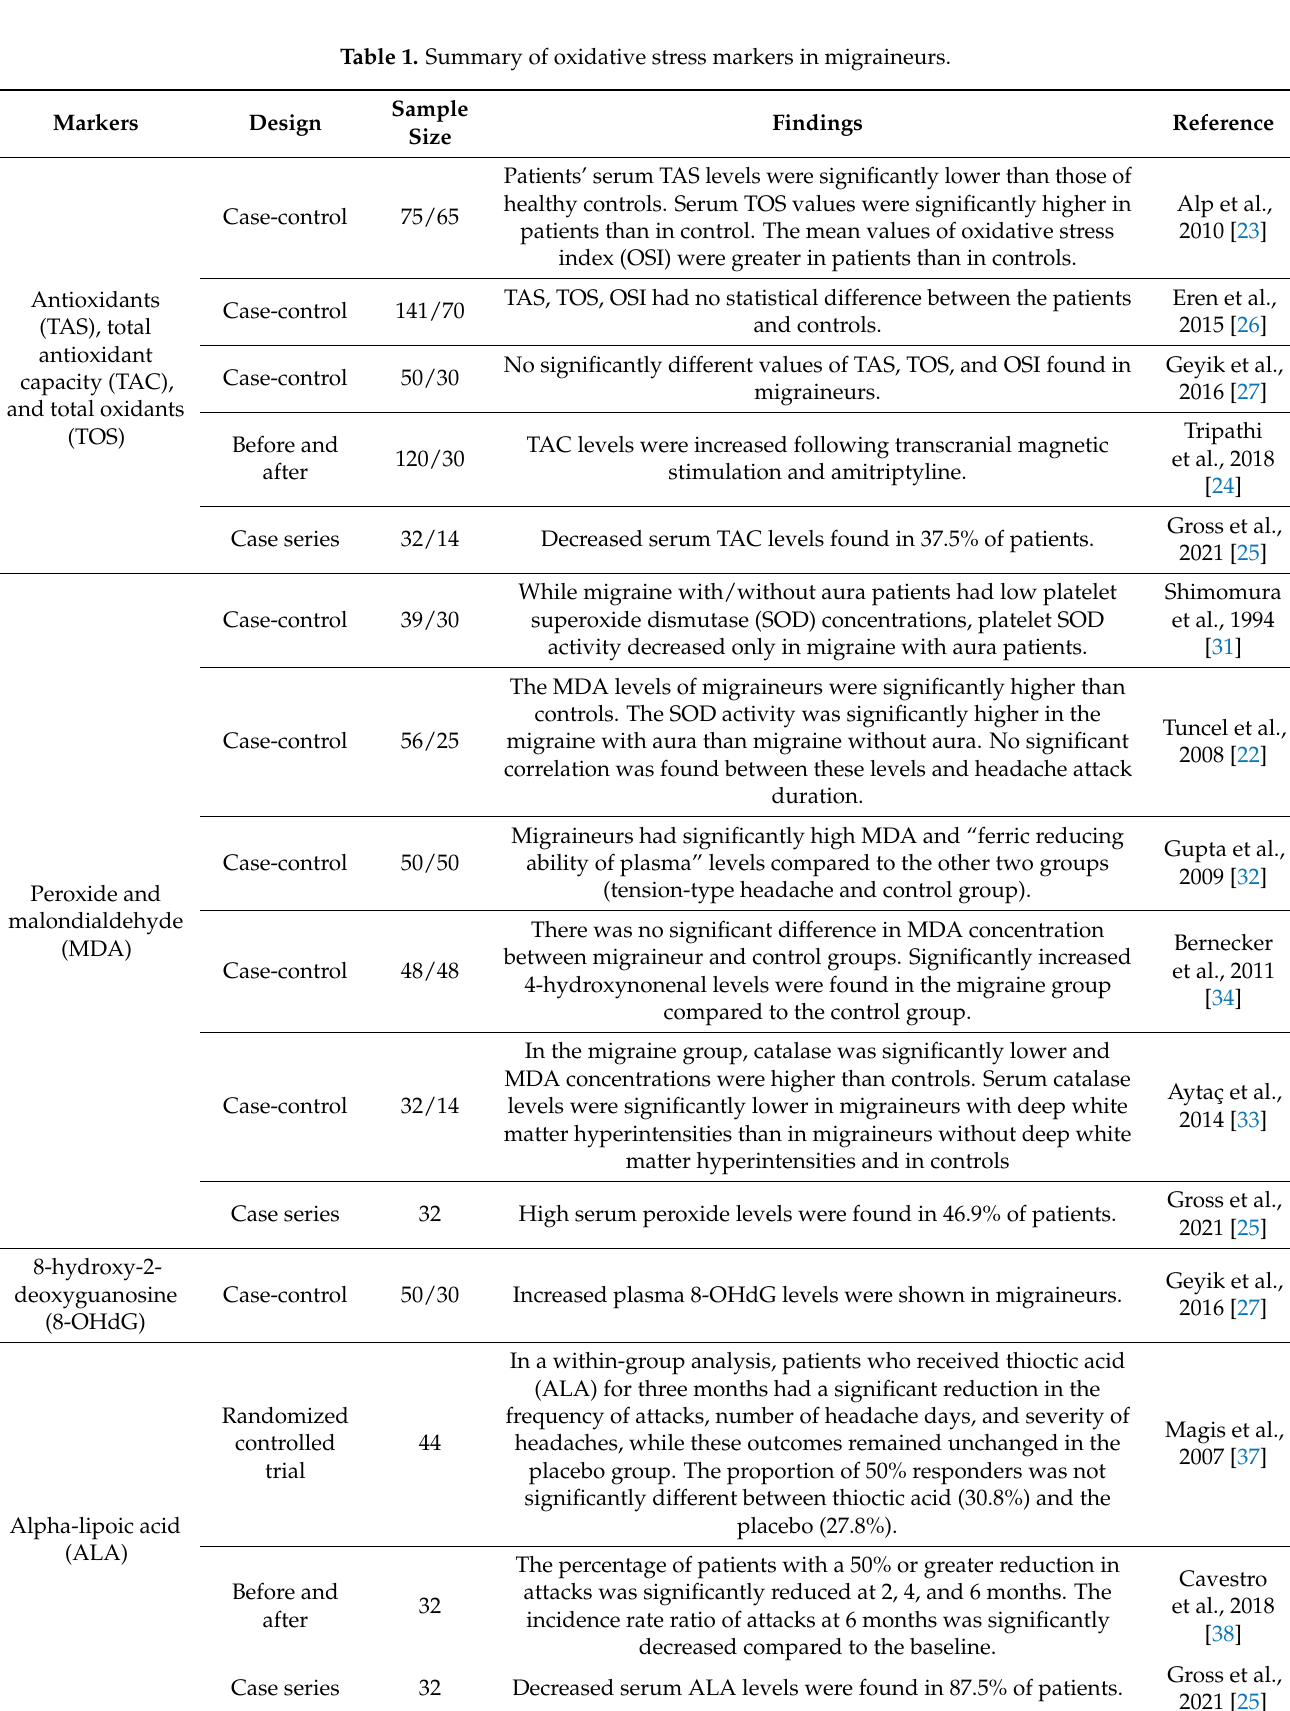
Table 1. Summary of oxidative stress markers in